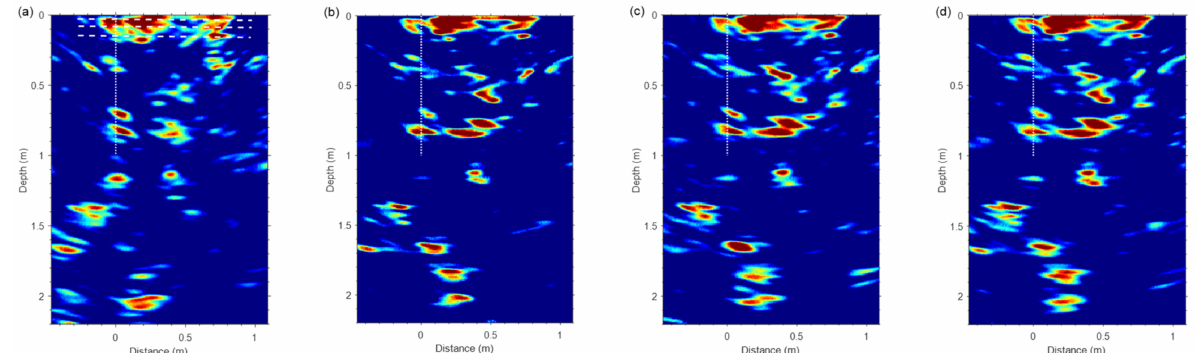
Figure 5. ( a ) Imaging result of the pre-drilling data. ( b – d ) Imaging results of the other three post- drilling data. The vertical dotted lines in these images indicate the drilling trajectory of the drill. The horizontal dashed lines in Figure 5a show the position of ground reflection. The background with low intensity represents lunar soil with uniform density, while high intensity in these figures indicates strong radar echoes from buried objects denser than lunar soil. The three post-drilling imaging results are almost identical. There is a little difference between the pre-drilling and post-drilling